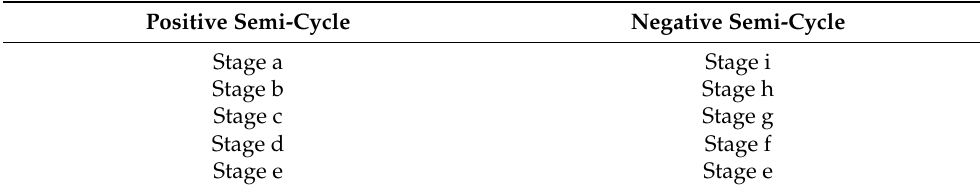
Figure 4. Different DAB stages, entitled as they are labelled.